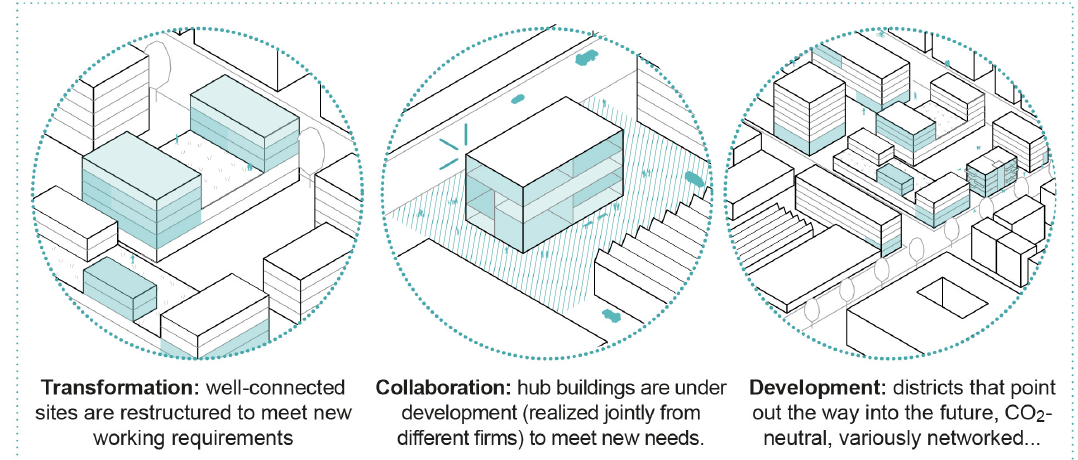
Figure 3. Types of connecting professional activities (marked in green; see descriptions in Subsections 3.3.1—3.3.3). employees, but can also be used by registered users or the general public. Some companies open some areas (often the ground floor spaces) to the public, as the LinkedIn co‐working space